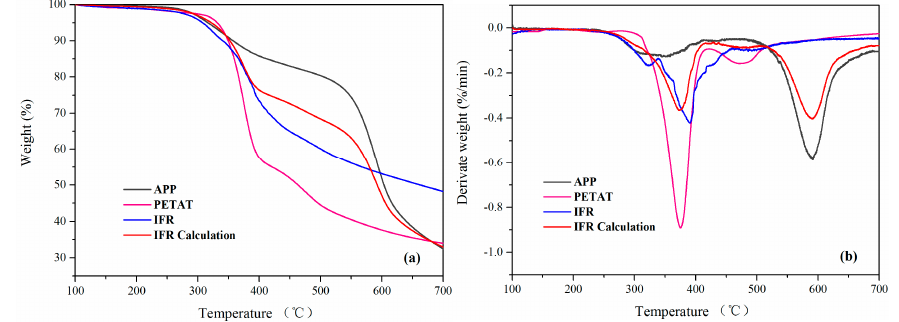
Figure 5. ( a ) TGA and ( b ) DTG ( thermogravimetric-derivative thermogravimetric ) curves of APP (Ammonium polyphosphate), PETAT, IFR (intumescent flame retardants), and IFR calculation under N 2 . Table 2. TGA and DTG data of APP, PETAT, IFR, and IFR calculation under N 2 . Samples